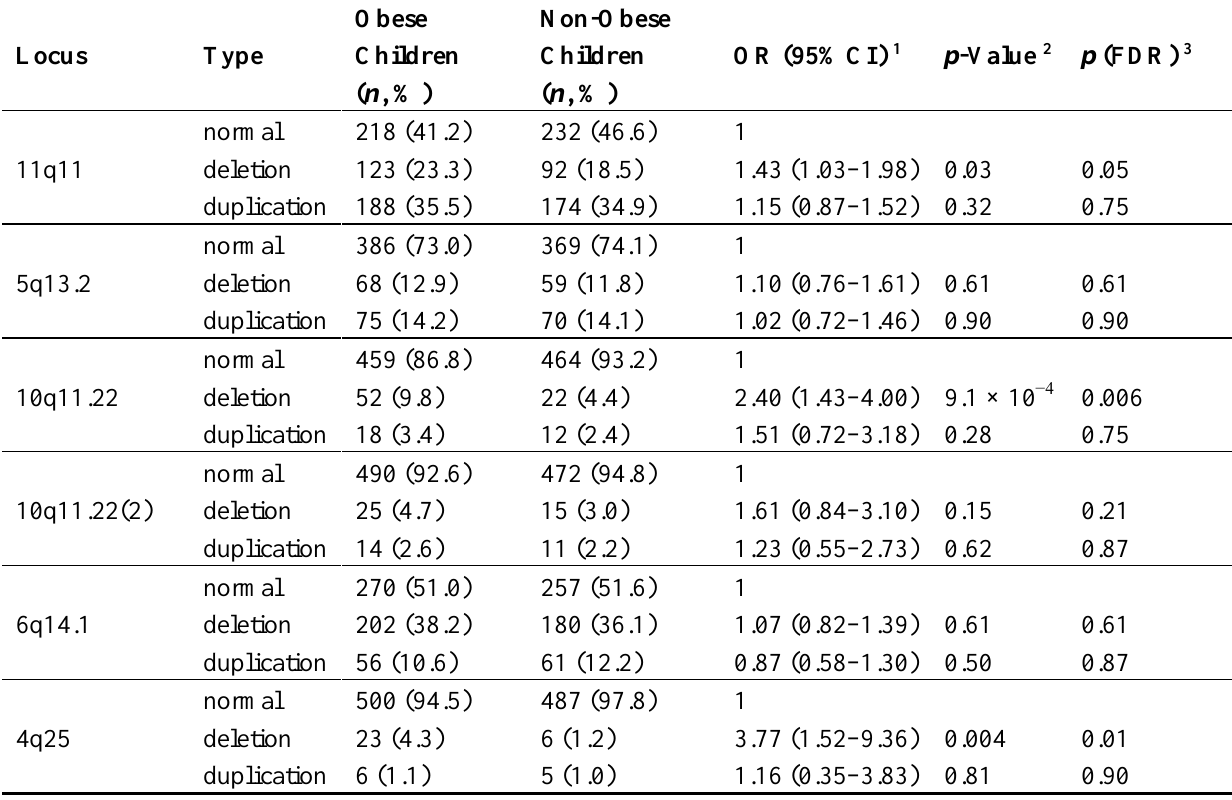
Table 3. Associations between candidate CNV loci and the risk of obesity. Locus